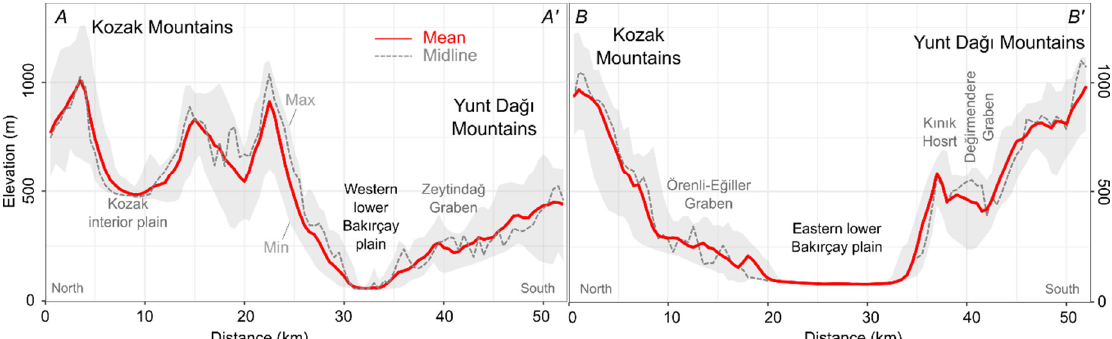
Figure 6. Swath profiles (for location see Figure 1A), indicating distinctly asymmetrical geomorphological characteristics between the Northern Highlands and Yunt Dağı Mountains surrounding the western lower Bakırçay plain (A–A’) and the eastern lower Bakırçay plain (B–B’). Note: 20× vertical exaggeration.